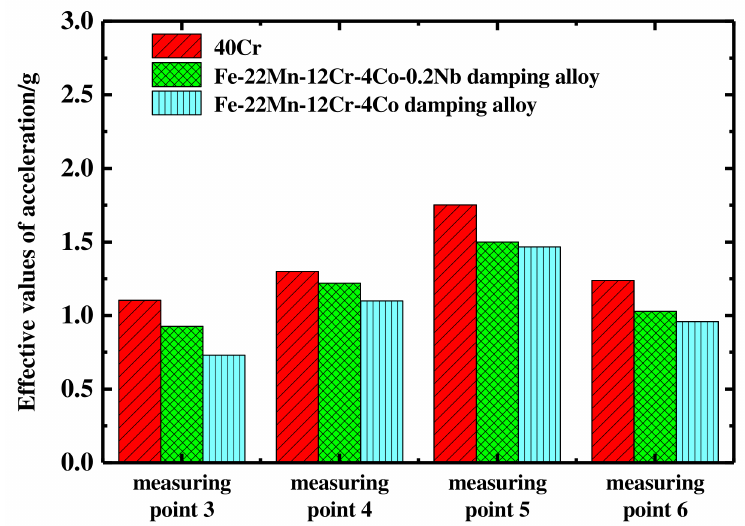
Figure 21. Comparison of vibration acceleration effective values of different material gear under 900 rpm 10 N · m working conditions.